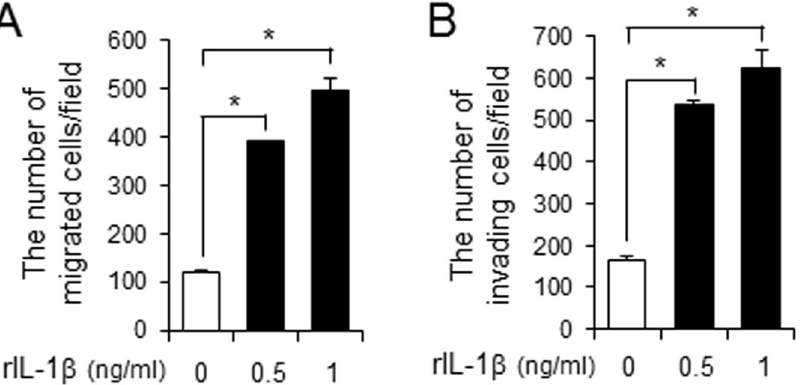
Figure 1. IL-1 β increases the metastatic potential of melanoma cancer cells. ( A , B ) B16F10 cells were plated in upper chamber of transwell. Serum-free medium containing recombinant IL-1 β (0.5, 1 ng/ml) was placed in the bottom chamber. After 24 hr, the migration or invasion of B16F10 cells was determined. Values are means ± SEM (n = 3). * p <